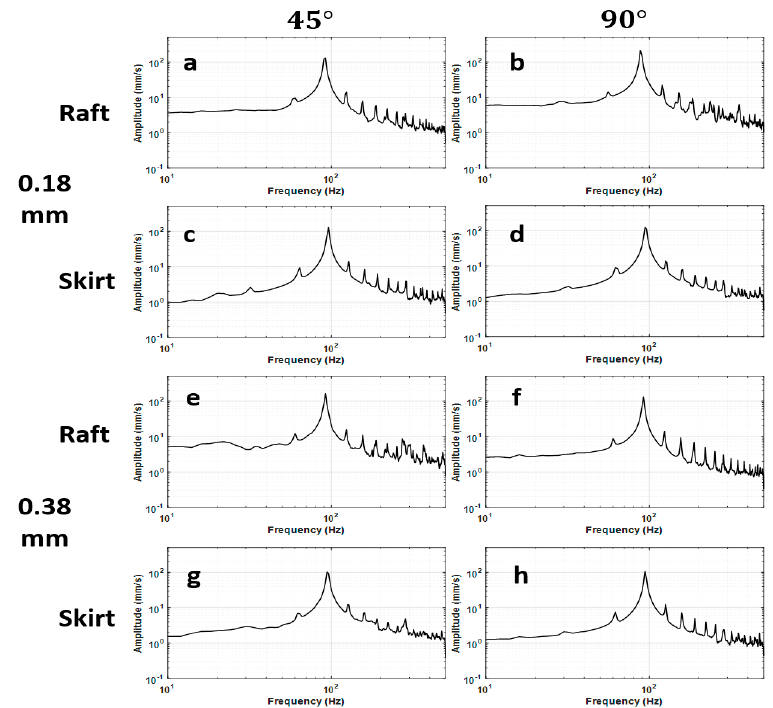
Figure 7. Frequency-domain response of the 3D printed cantilevers: ( a ) R-45-0.18 mm, ( b ) R-90-0.18 mm, ( c ) S-45-0.18 mm, ( d ) S-90-0.18 mm, ( e ) R-45-0.38 mm, ( f ) R-90-0.38 mm, ( g ) S-45-0.38 mm, and ( h ) S-90-0.38 mm.